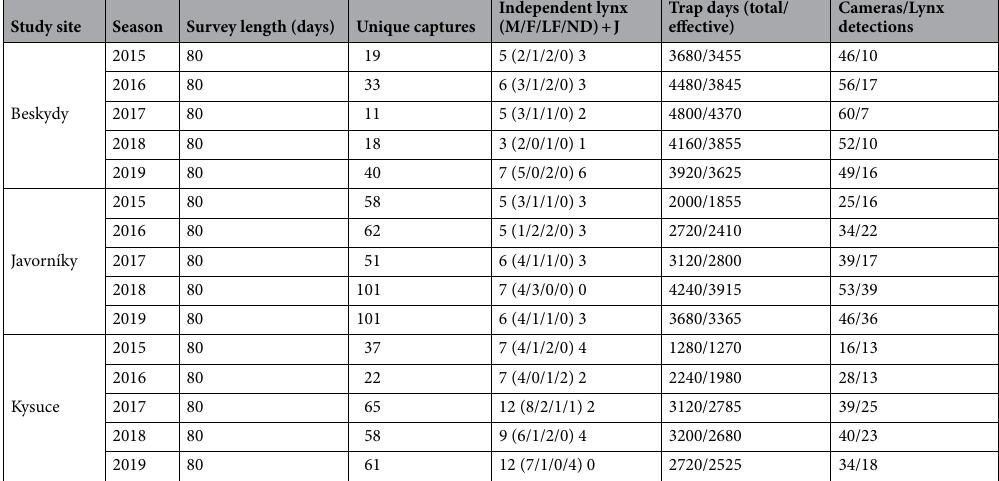
Table 1. Basic parameters of the systematic lynx camera-trapping in five consecutive seasons within three study sites in the Western Carpathians. M male, F female, LF leading female, ND not determined, J